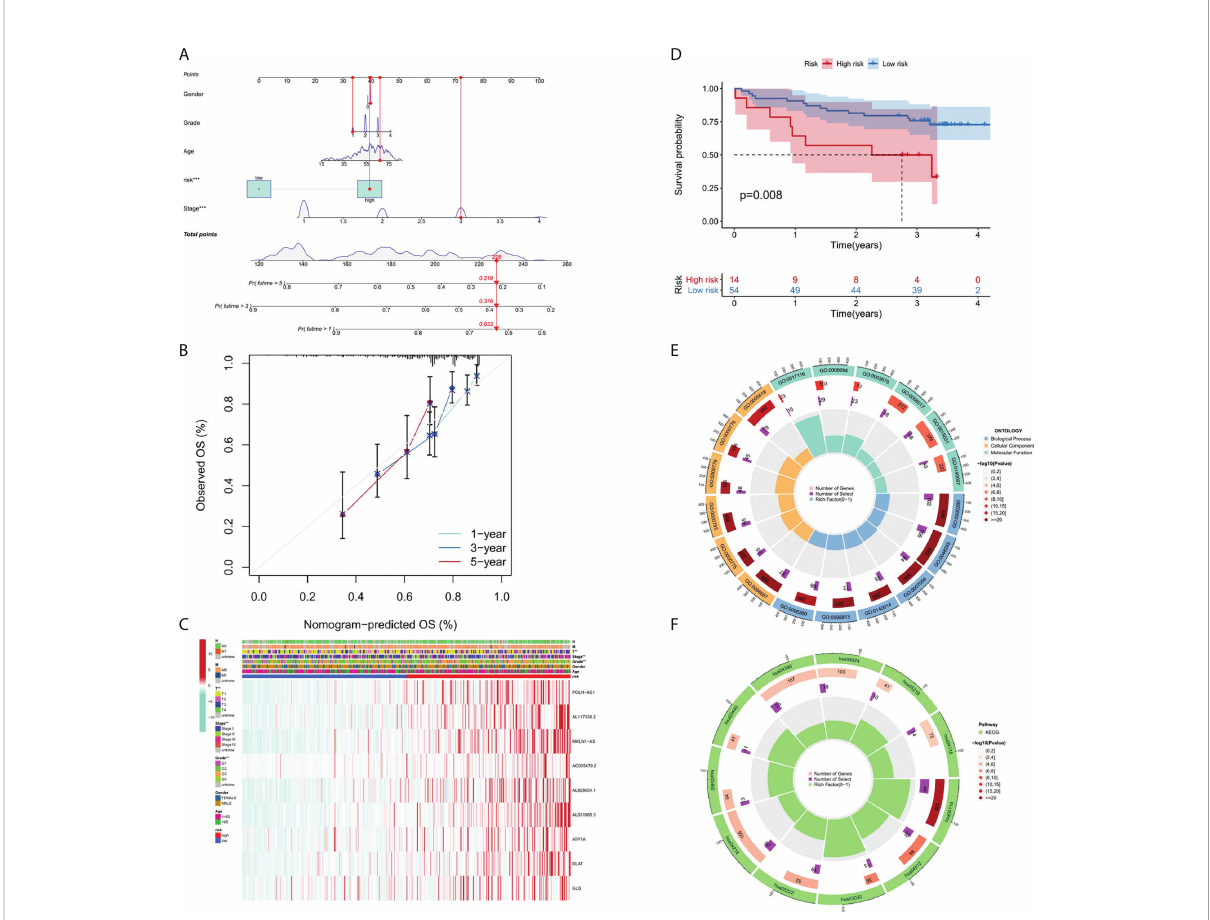
FIGURE 4 Nomogram, calibration curves and functional enrichment analysis. (A) Nomograms predicting 1-year, 3-year and 5-year OS for patients with liver cancer. (B) Nomogram model calibration curve. (C) Heatmap displaying expression pro fi le of the 9 genes and correlation between clinical features and risk score. (D) Results of Kaplan-Meier analysis for the different RS score groups in GEO dataset. (E) Results of GO enrichment analyses. (F) Results of KEGG enrichment